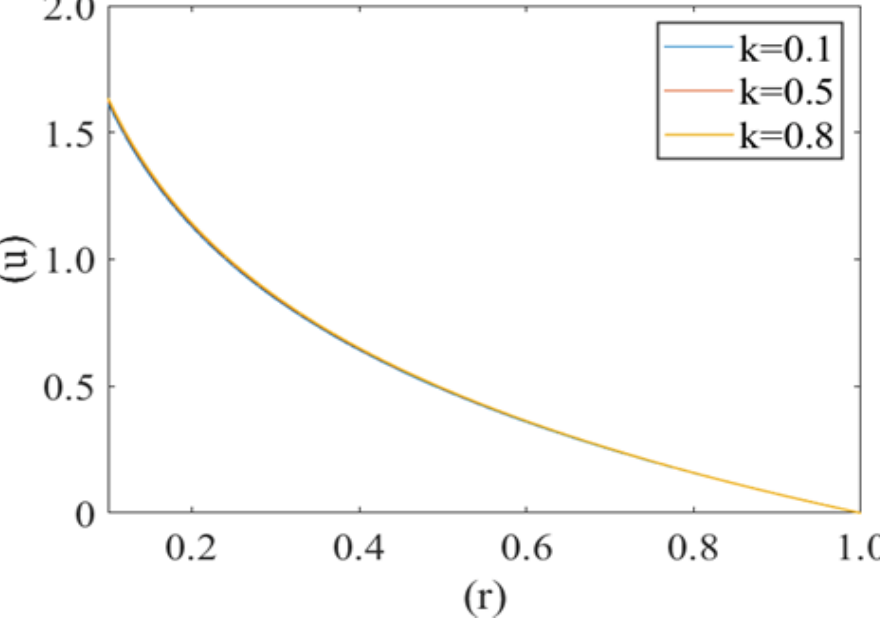
Figure 3. Variation of axial velocity component ( u ) of the plasma film with a deformed cell radius ( r ) for different values of radius of curvature ( k ) of deformed shape of cell paraboloid Re = 0.25, P1 = 2, P2 = 2.5. Figures 4 and 5 are computed for the axial velocity component of plasma in the capillary for different values of local and mean pressures respectively (i.e., P1 = 2, 5, 8 and P2 = 2, 4, 6). Axial velocity decreases from the axis to the capillary wall along the cell surface i.e., it is at its